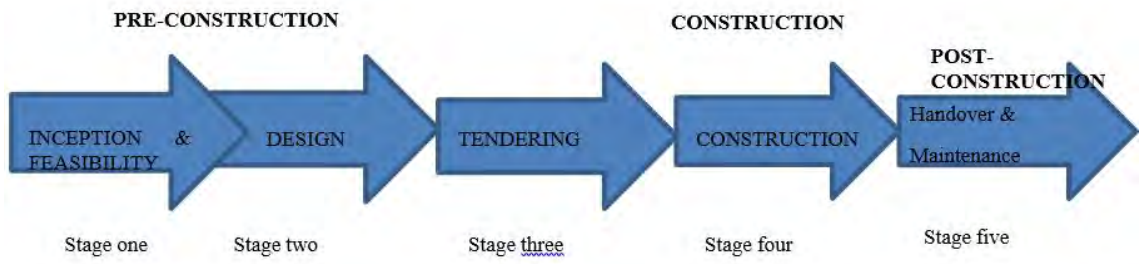
Figure 2. Construction Project Management. Stages (K.S., I. H. S. (2002).